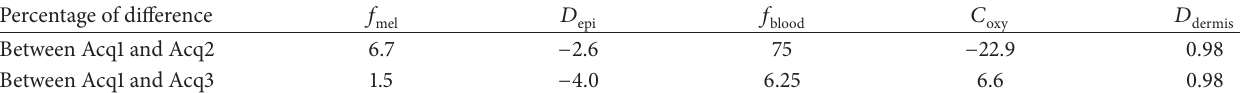
Table 9: Percentage of difference between baseline acquisition (Acq1) and before occlusion release (Acq2) and one minute after release for the 5 parameters (Acq3) for the average data acquired on 4 healthy